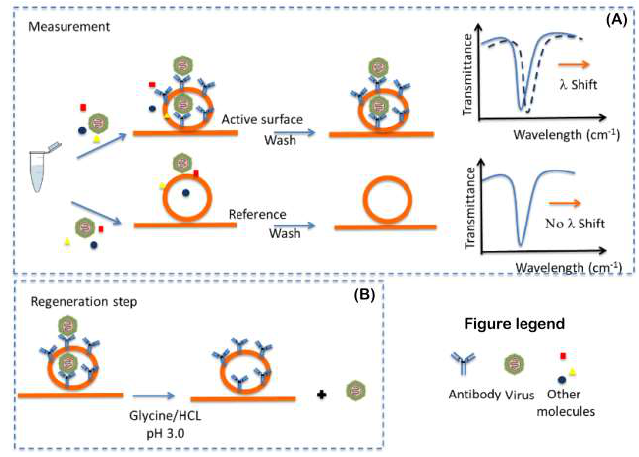
Figure 4. Functionalized photonic integrated circuit (PIC) surface measurement ( A ) and regeneration step ( B ).